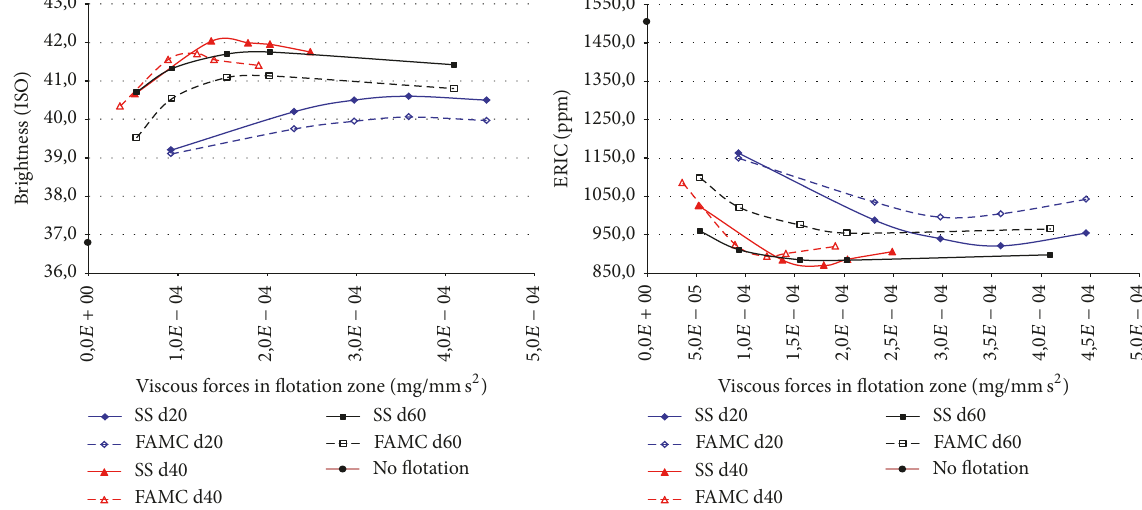
were isolated from the 6 h point of extraction. This